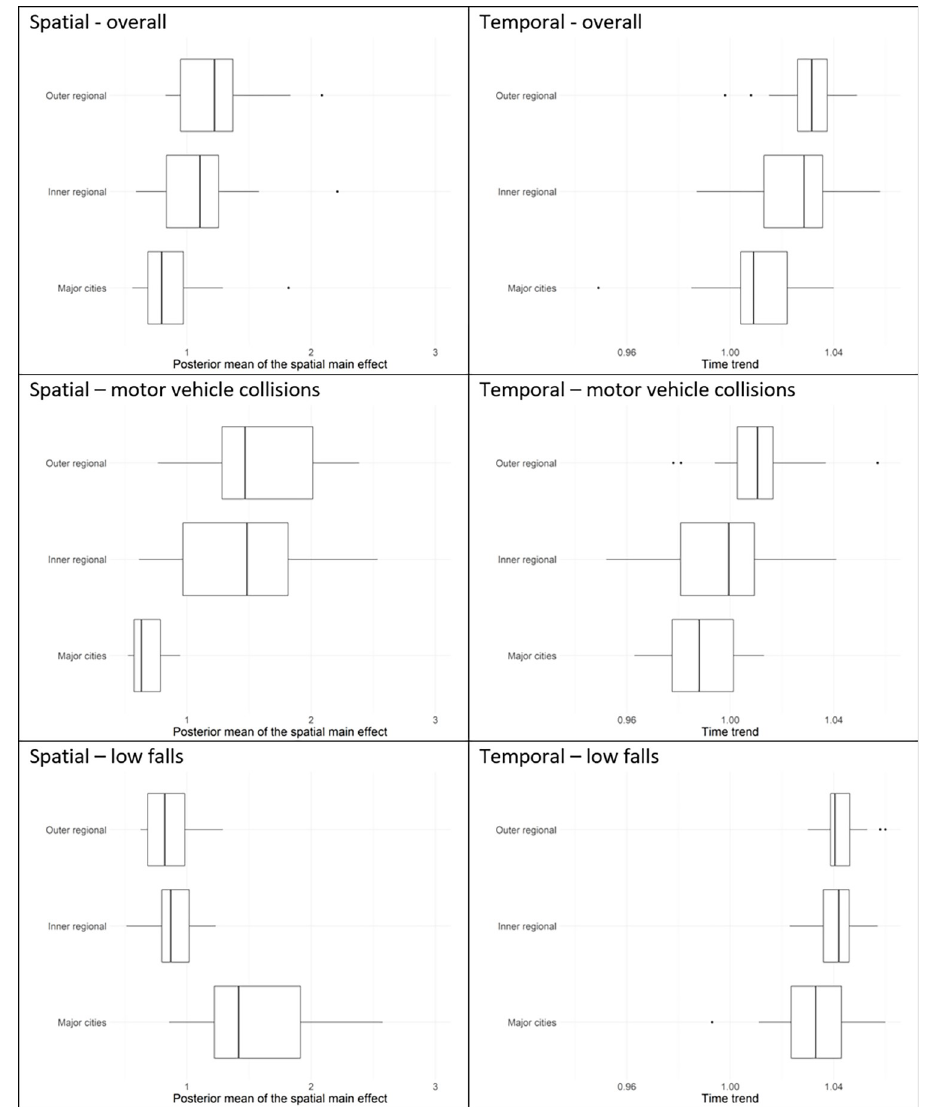
Fig 5. Box plots of posterior means of area-specific relative risk (‘Spatial’) and area-specific yearly multiplicative change in risk (‘Temporal’) of major trauma, shown by major trauma overall, motor-vehicle collisions, and low falls, and by the Accessibility and Remoteness Index of Australia (ARIA), which classifies an LGA as a major city, as inner regional, or as outer regional. The middle line of the box represents the median, with the lower and upper box ranges reflecting lower and upper quartile, respectively. The upper/lower whiskers reflect the largest/smallest observation less than or equal to ± 1.5 times the interquartile